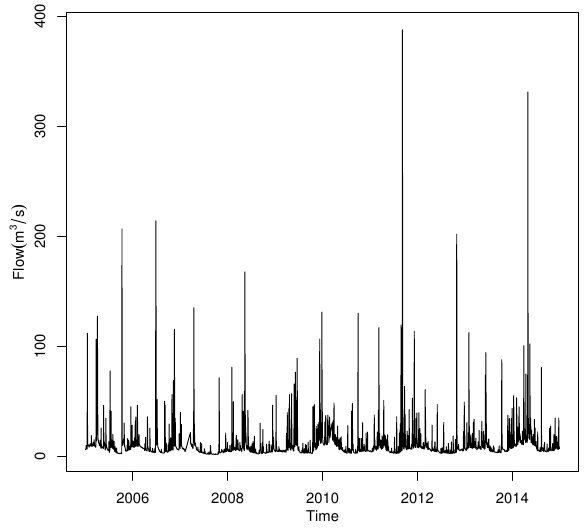
Figure 16. Time series of the Patuxent river daily flow.